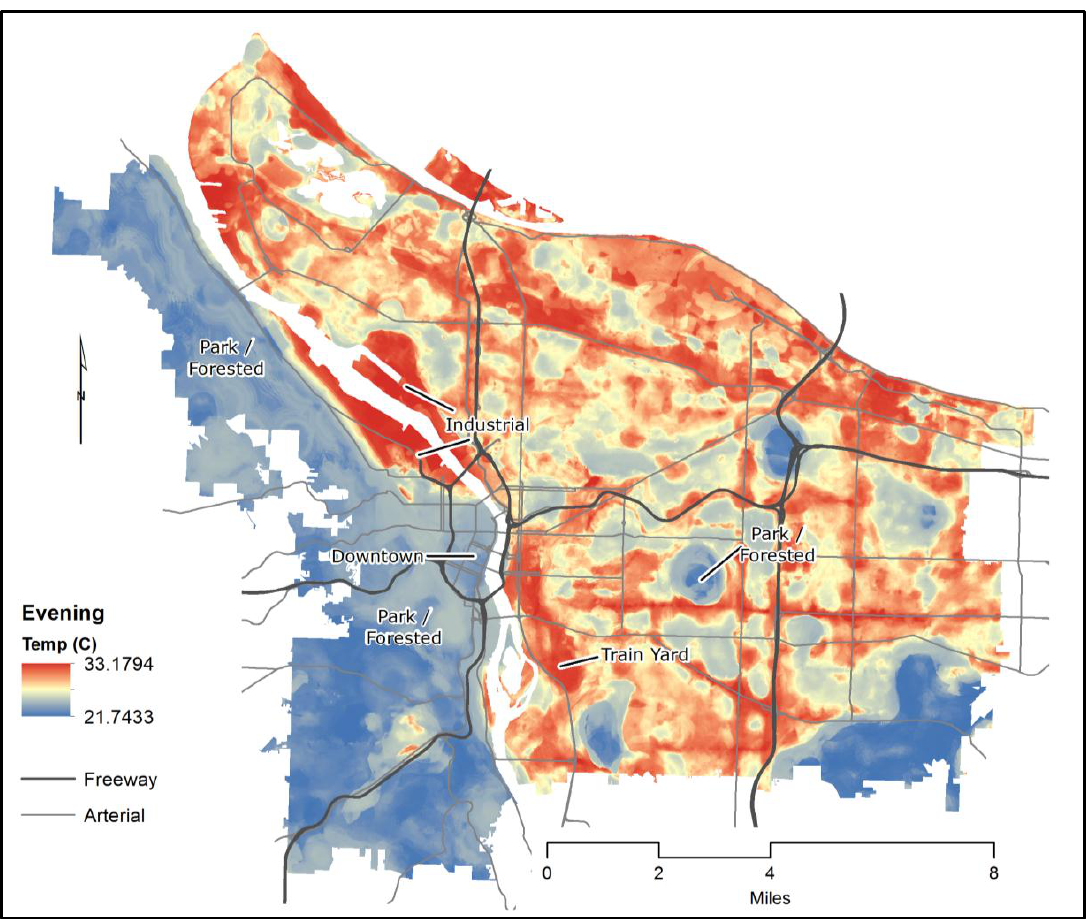
Figure 6. Evening UHI modeled raster surface. The river has been masked out visually, however summary statistics incorporate its values.